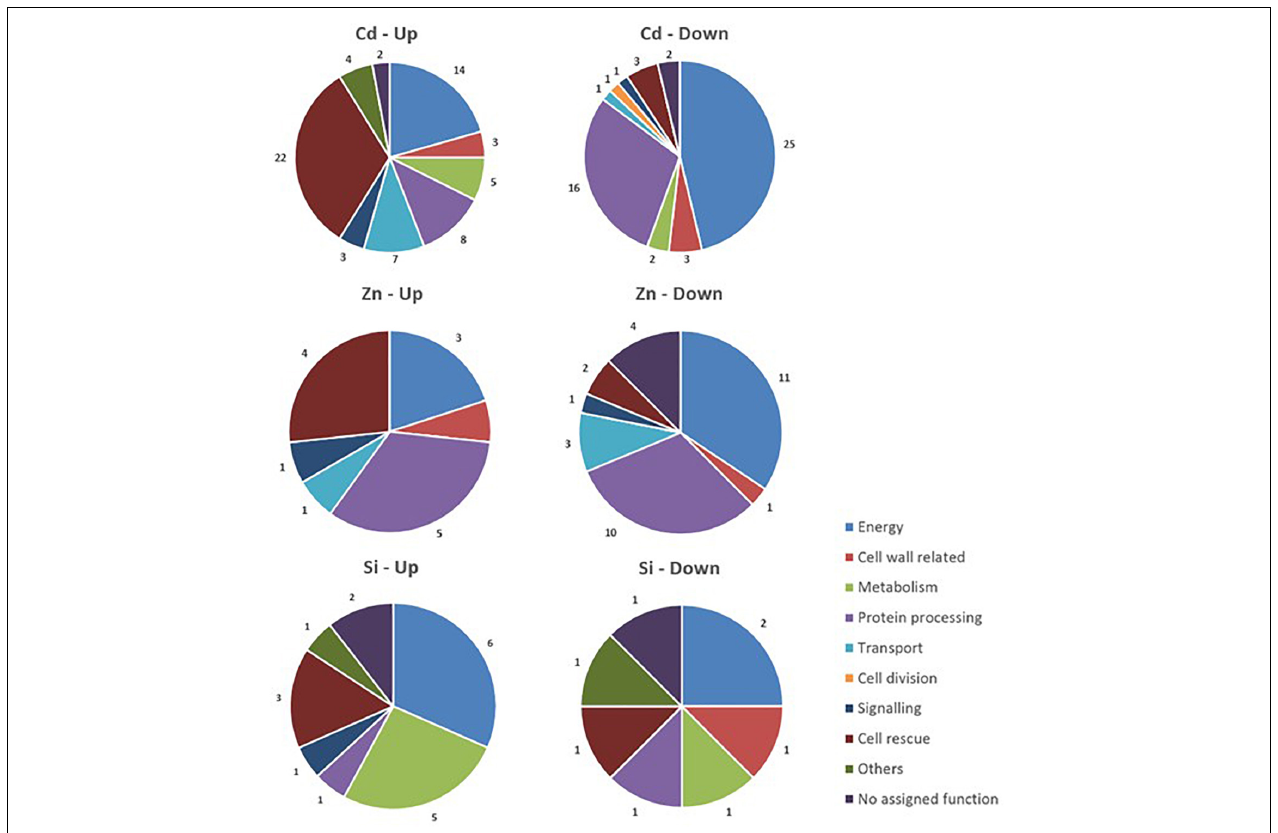
FIGURE 5 | Functional classification of proteins with significant quantitative changes in abundance in hemp leaves in response to Cd, Zn, and Si. Seedlings were exposed for 1 week either to Cd 20 µ M, Zn 100 µ M, or Si 2 mM, and proteins were extracted from leaves. Mixed treatments (CSi, CdSi, and ZnSi) are not indicated for the sake of